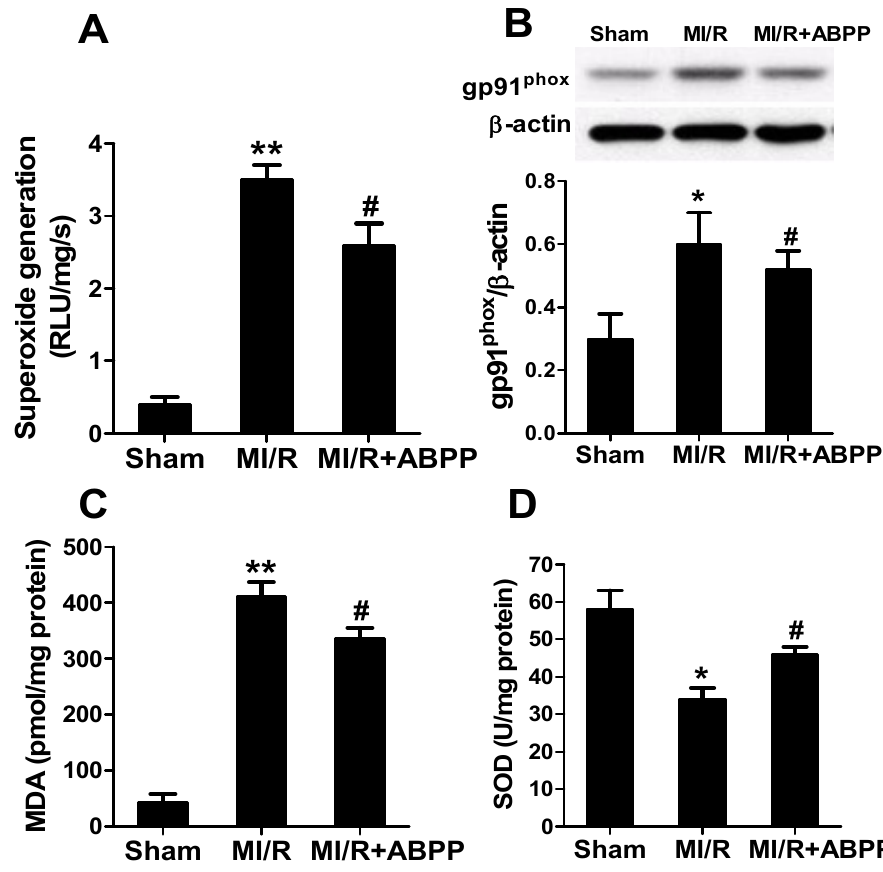
Figure 4. Achyranthes bidentata polypeptides (ABPP) preconditioning reduced